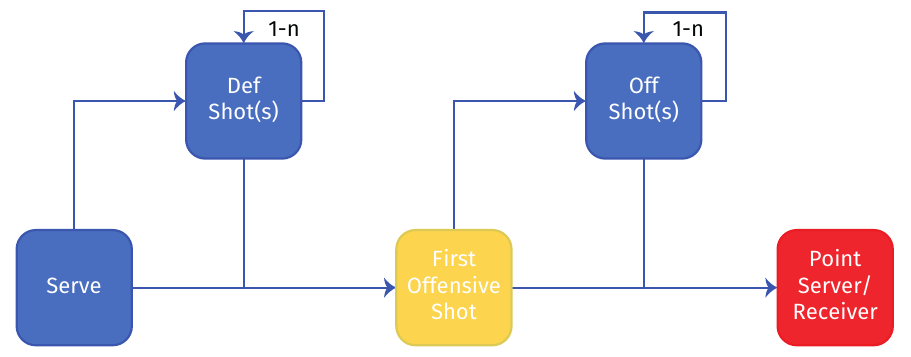
Figure 1. Process model of table tennis rally with first offensive